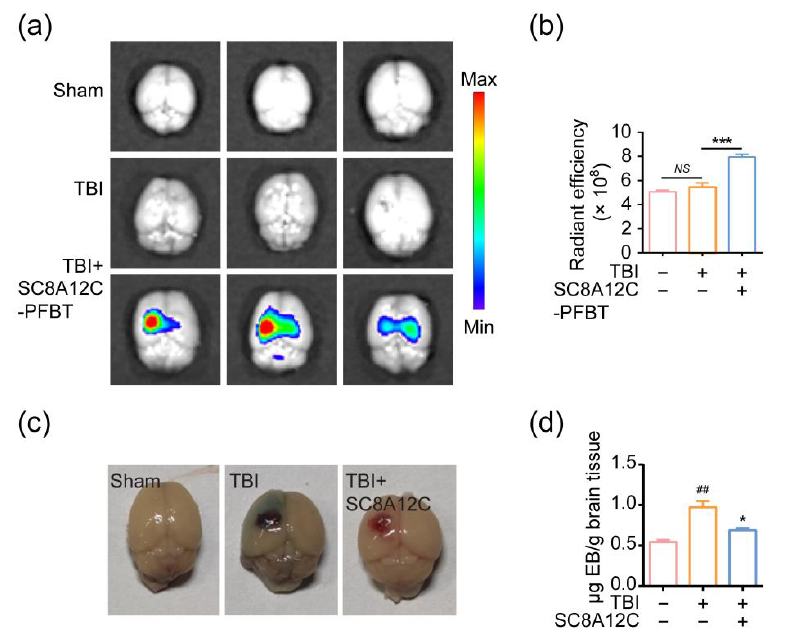
Figure 5. ( a ) Fluorescence imaging of the brain was performed by IVIS system; ( b ) the radiant efficiency in panel a; ( c ) EB staining imaging; and ( d ) quantitative analysis of the content of EB dye by UV spectrophotometry, respectively ( n = 3). ## p < 0.01 vs. sham group; * p < 0.05, *** p < 0.001 vs. TBI group, NS: No significance.